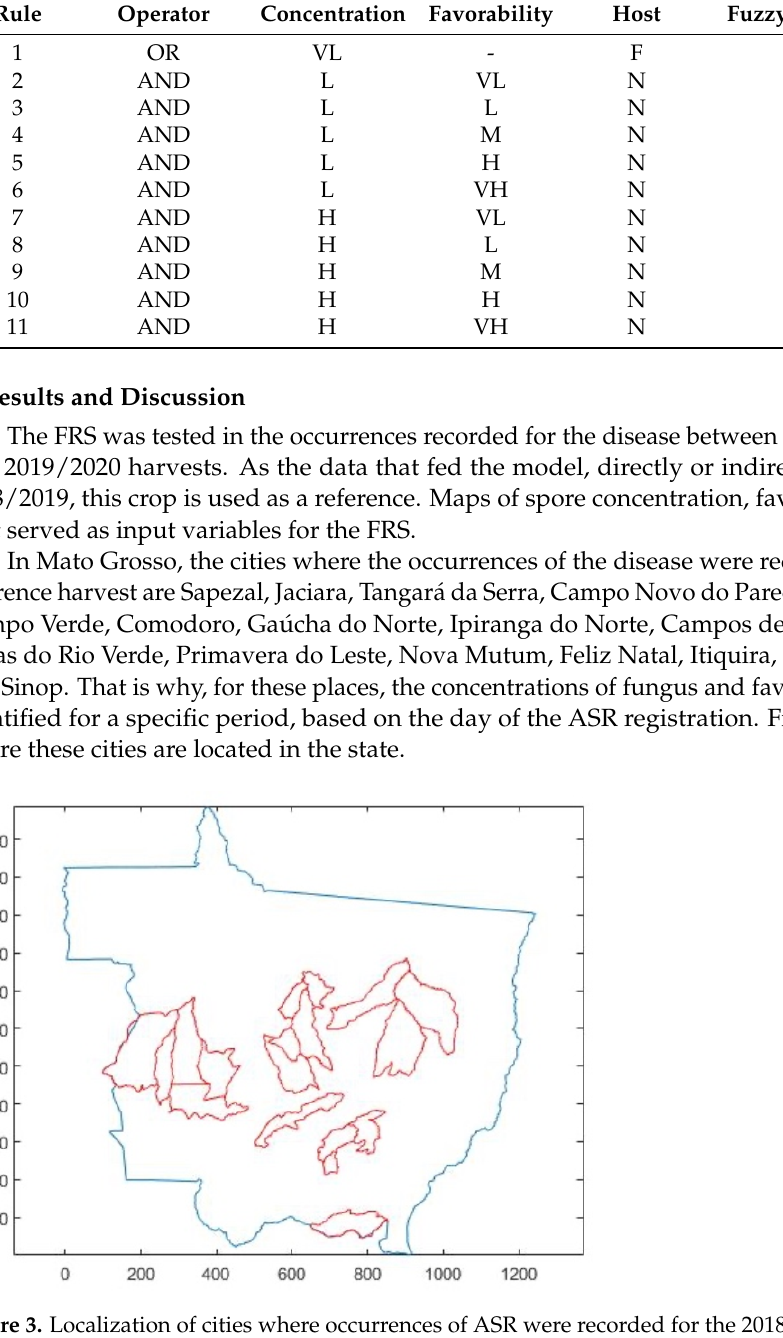
Figure 3. Localization of cities where occurrences of ASR were recorded for the 2018/2019 crop. Some parameters used in the simulation of concentration varied in time and space, as was the case with transport and decay. The diffusion coefficient was based on the research of [31], and the values assigned to the parameters source and θ , in the searches of [36,37]. For instant zero, 31 October was considered, which is the day of the first occurrence of the disease recorded in the 2018/2019 harvest. In addition, for the other crops considered, these records took place from November or December. The concentrations were calculated until 30 April, when the soybean harvest for Mato Grosso ends, according to [38]. Figure 4 depicts the scattering of spores for the last day of each